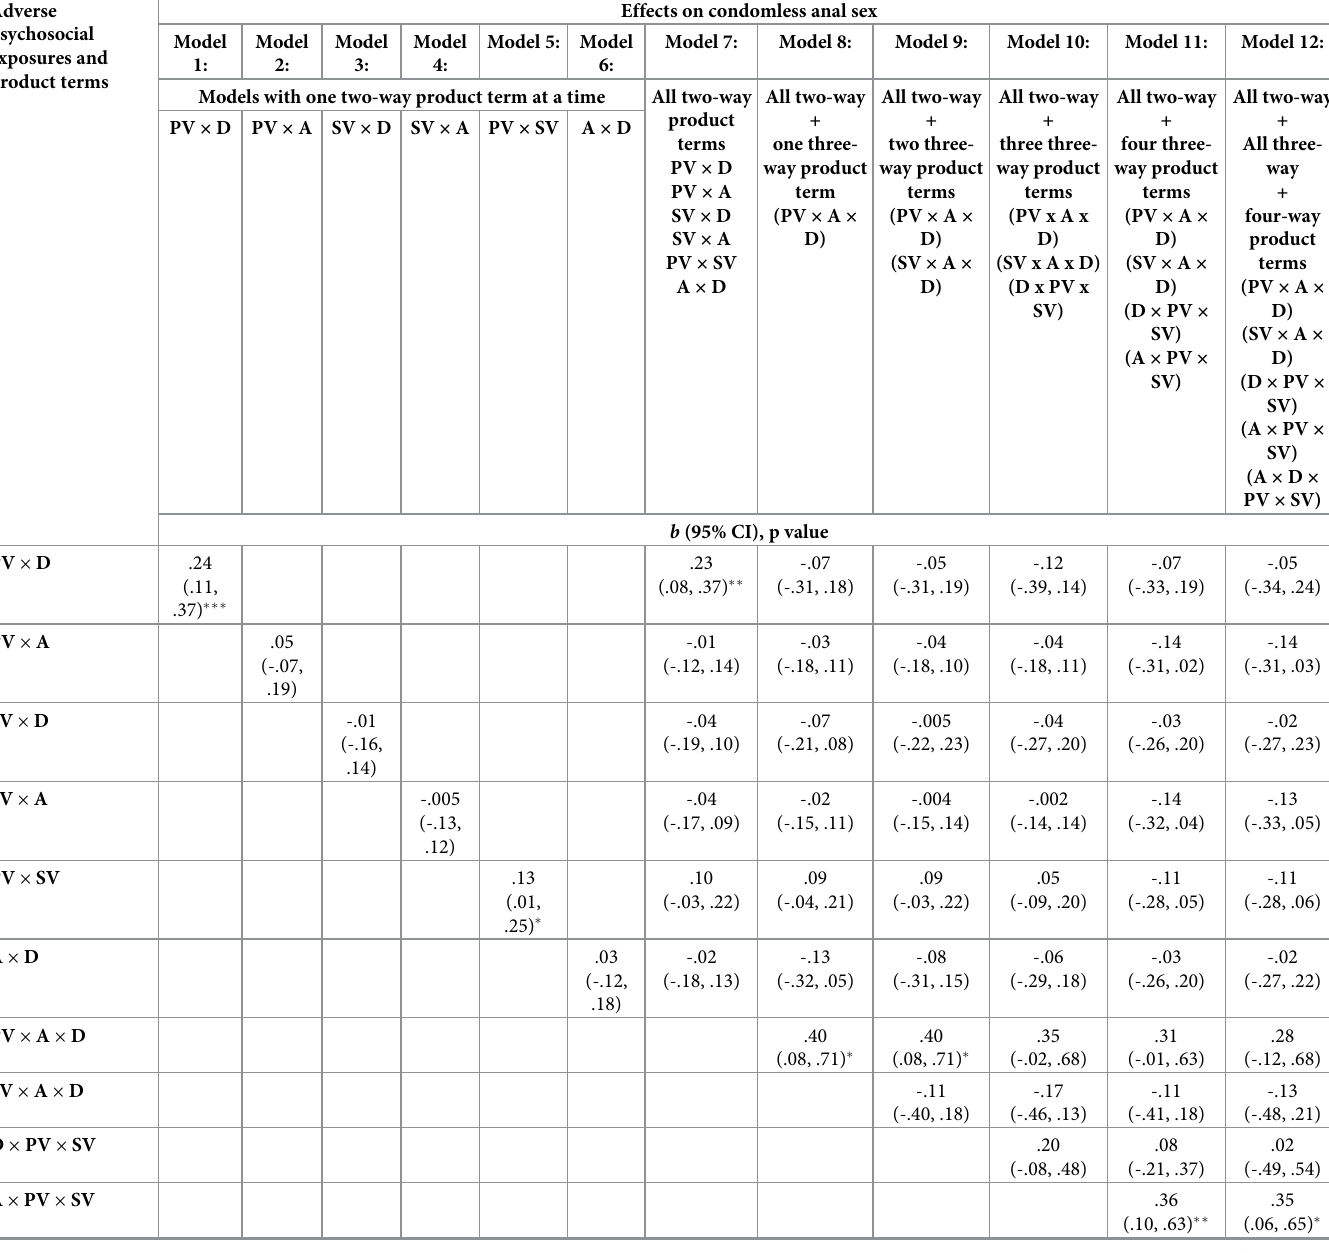
Table 5. Effect of adverse psychosocial exposures on condomless anal sex with male partners among HIV-negative transgender women: Measures of additive Two-/ Three-/Four-way interactions between physical violence, sexual violence, drug use, and frequent alcohol use (N = 4,607). Adverse